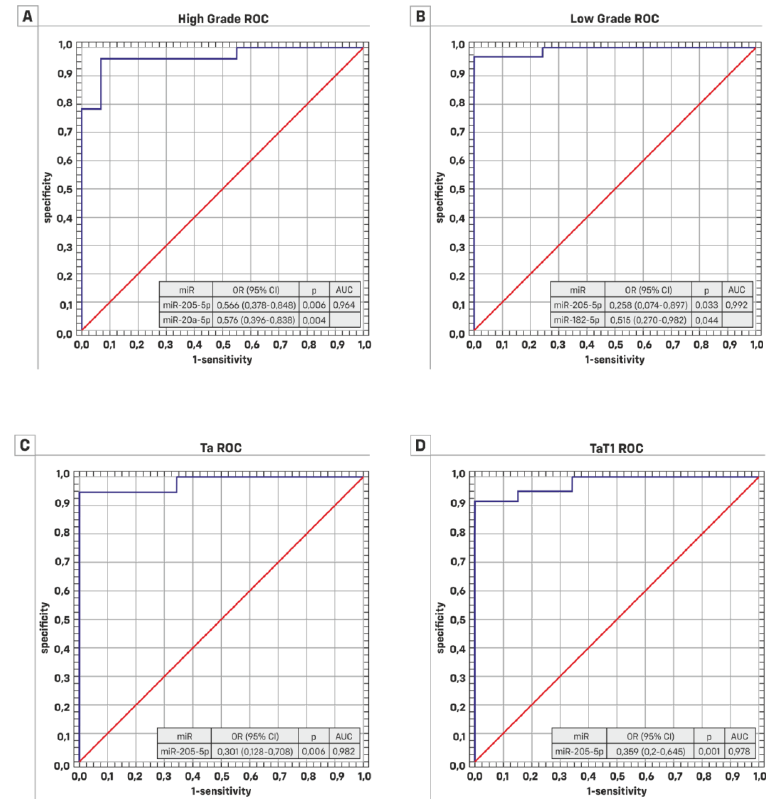
Figure 4. Multivariate logistic model of one or two signature microRNAs (miRNAs): ( A ) For high grade tumors, miR-205-5p and miR-20a-5p are the best classifiers; AUC = 0.964. ( B ) For low grade tumors, miR-205-5p and miR-182-5p are the best classifiers; AUC = 0.992. ( C ) for Ta and ( D ) for TaT1, mir-205-5p is the best classifier; AUC = 0.982 and AUC = 0.978 respectively. (OR—odds ratio; CI— confidence interval; AUC—area under curve).